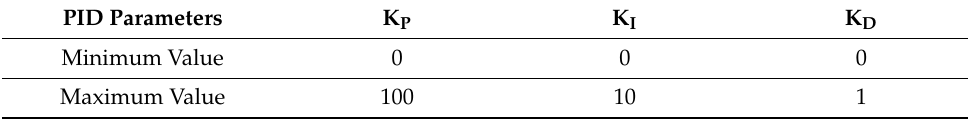
Table 2. Band of PID parameters.